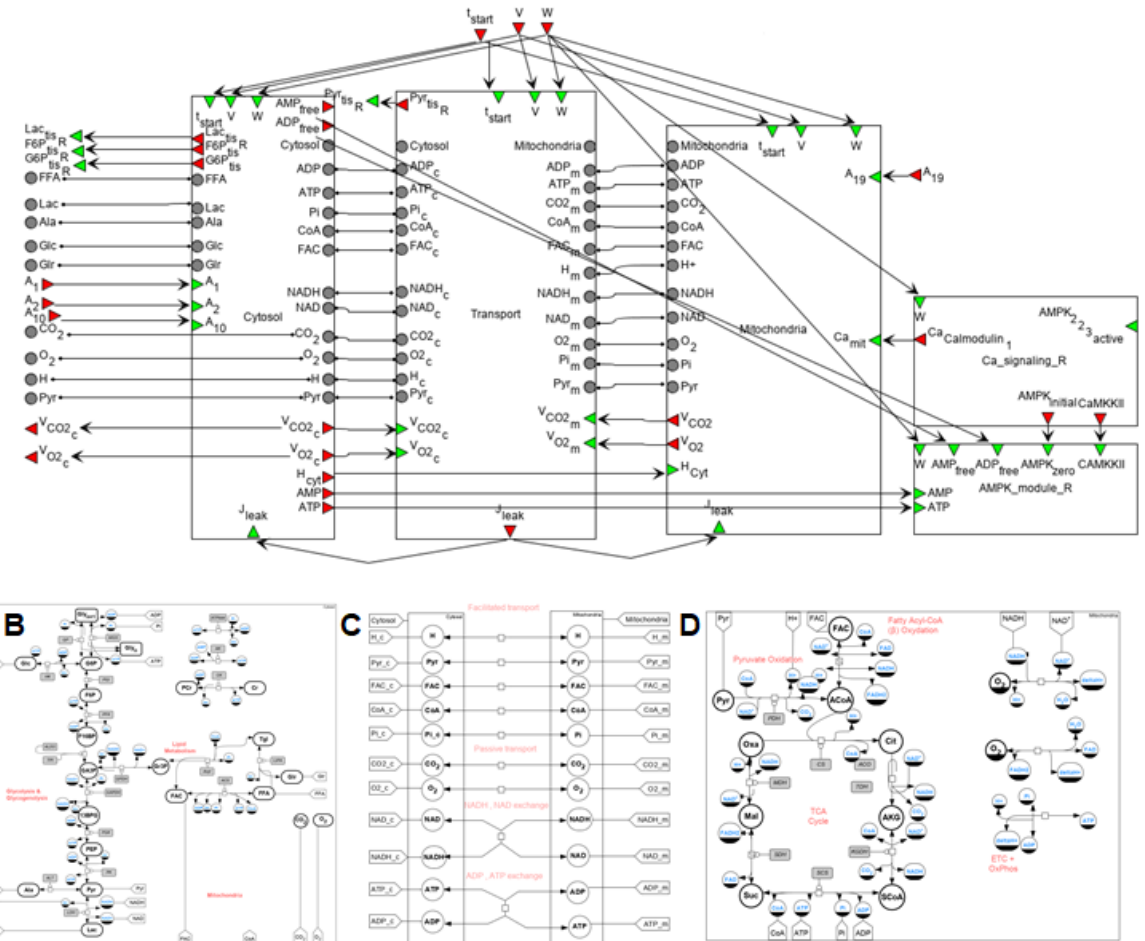
Figure 6. A general SBGN diagram of the modular model describing metabolism in human muscle fibers ( A ) taking into account metabolic processes in the cytoplasm ( B ) and the mitochondrion ( D ), and transport reactions between two compartments ( C ) as well as modules of the Ca 2+ -dependent signaling pathway and AMPK activity considering different isoforms. Designations of input/output/contact ports are described above in the main text. The vertices of the bipartite graph in the Cytosol/Mitochondrion and Transport submodules correspond to the respective biochemical or transport reaction depending on the submodule. Each fiber type module also comprises submodules of Ca 2+ - and AMPK-dependent signaling pathways. All details for each submodule and zoomed-in subfigures are in the Supplementary Material.